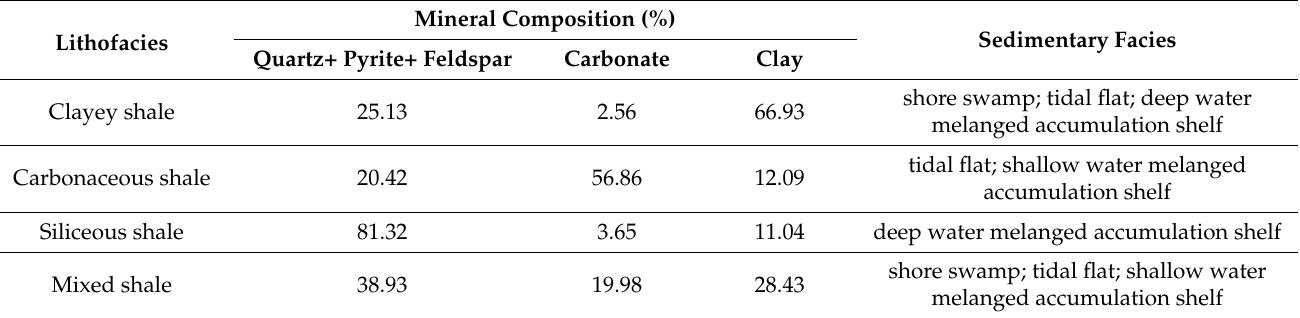
Table 2. Mineral compositions and sedimentary facies of the Longtan various shale.